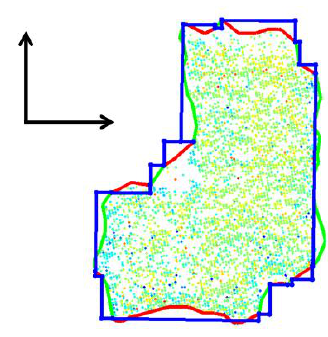
Figure 5: Illustration of building footprint reconstruction. The estimated dominant orientations, computed by the method described above, are shown by black arrows. Each edge of the coarsely reconstructed footprint is segmented (shown in green and red color) according to their parallelism with respect to the two dominant directions. Later, the final rectilinear shape (shown in blue color) of the building footprint is reconstructed by rectangular projection of each segmented edge onto its corresponding dominant